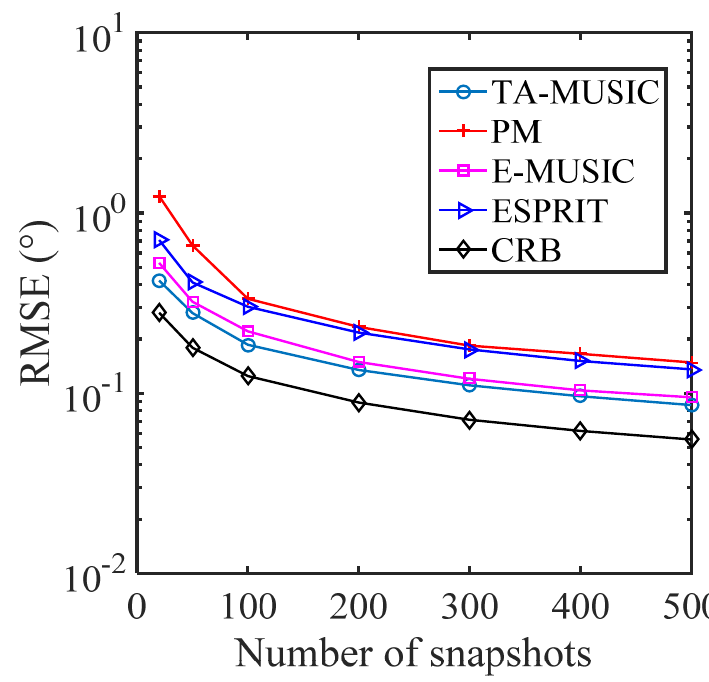
Figure 8. RMSE against number of snapshots for various algorithms.